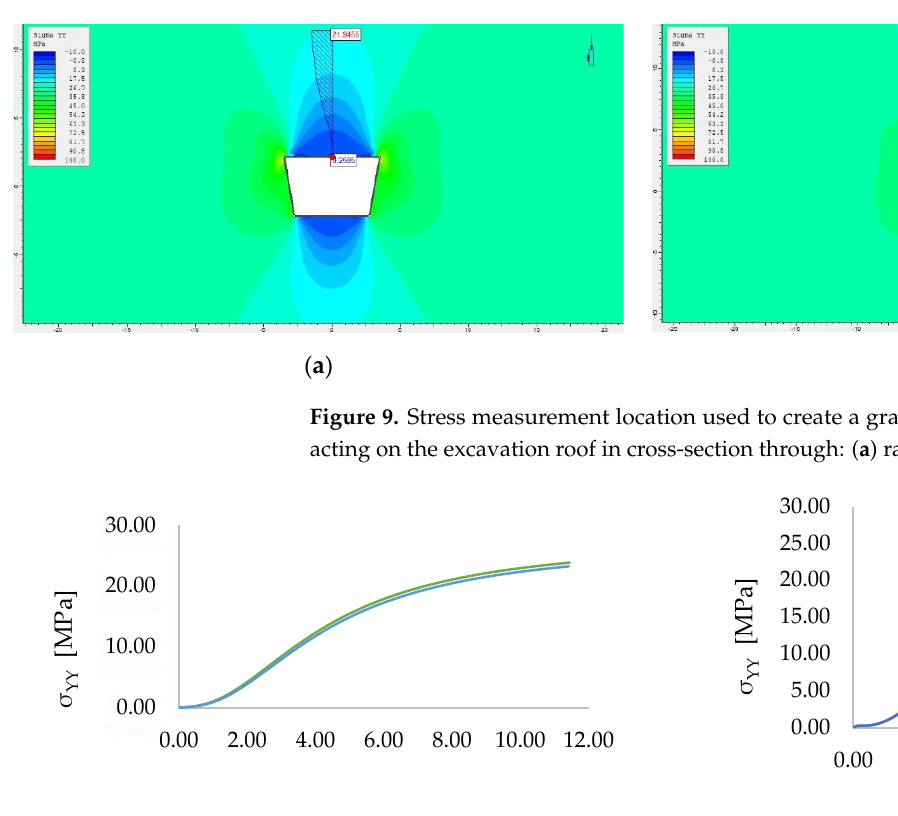
( b ) Figure 8. Close-up view of σ YY stresses values in the cross-section through entries drilled in: ( a ) sandstone, ( b ) dolomite. The location of roof stress measurement is presented in Figure 9. Graphs illustrating